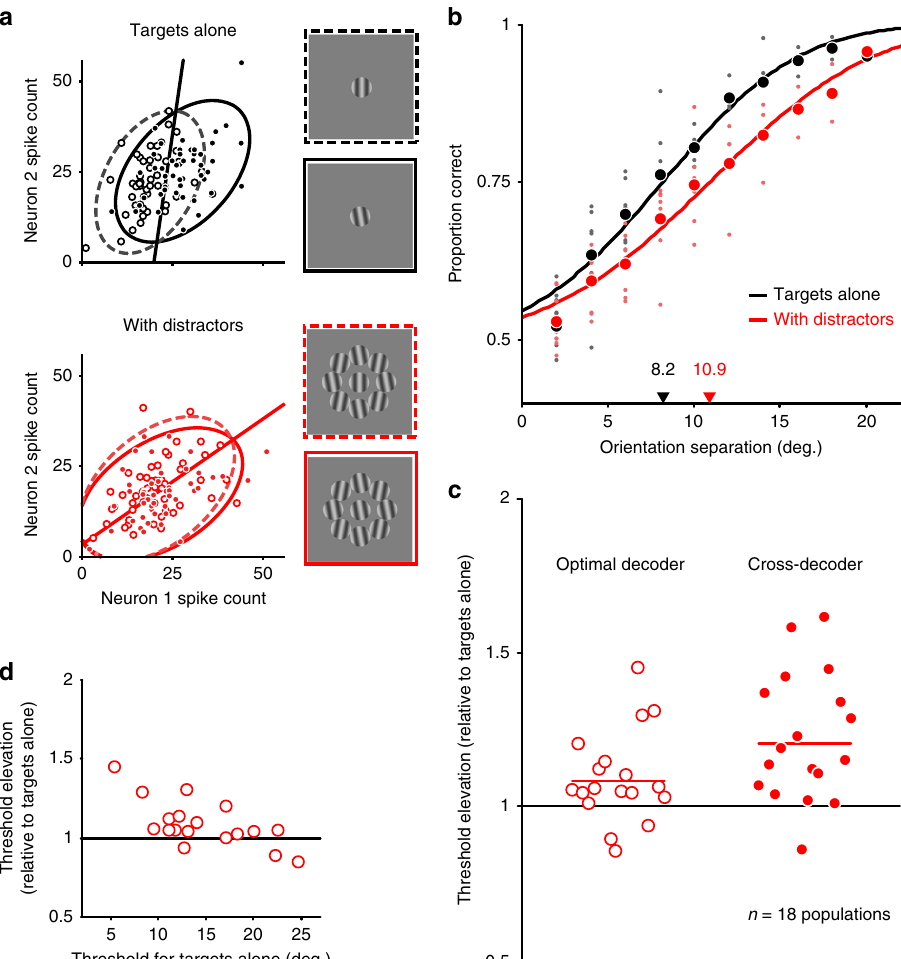
Fig. 3 Distractors reduce target orientation information in V1 populations. a Responses of a sample two neuron population to targets alone (black, top) and with distractors (red, bottom). Open and fi lled circles represent responses to two different target orientations. Ellipses indicate the 95% con fi dence interval of each response distribution. Linear discriminant analysis was used to identify the optimal classi fi cation boundaries to best separate the two response clouds (black and red lines). b Neurometric function for an example neuronal population, for targets alone (black) or with distractors (red). Each small point represents discrimination performance for one pairing of two targets of a given orientation separation. Large circles indicate the mean performance at each separation. Lines indicate fi ts of a cumulative normal distribution to the data. Threshold is de fi ned as the separation producing 75% correct performance. Arrows on the abscissa indicate thresholds. c Orientation discrimination thresholds with distractors, relative to thresholds for targets presented alone. Each point represents one V1 population. Open circles, left: thresholds for the optimal linear classi fi er (points are distributed along the abscissa for visibility). Filled circles, right: thresholds when the optimal classi fi er for responses to isolated targets is applied to responses to targets with distractors. d Discrimination threshold elevation (with distractors, relative to targets alone) as a function of discrimination threshold for targets alone. Source data are provided as a source data fi We fi rst evaluated how distractors affected neuronal respon- de fi ned as the ratio of the responses to targets with distractors relative to responses to targets presented alone. The modulation